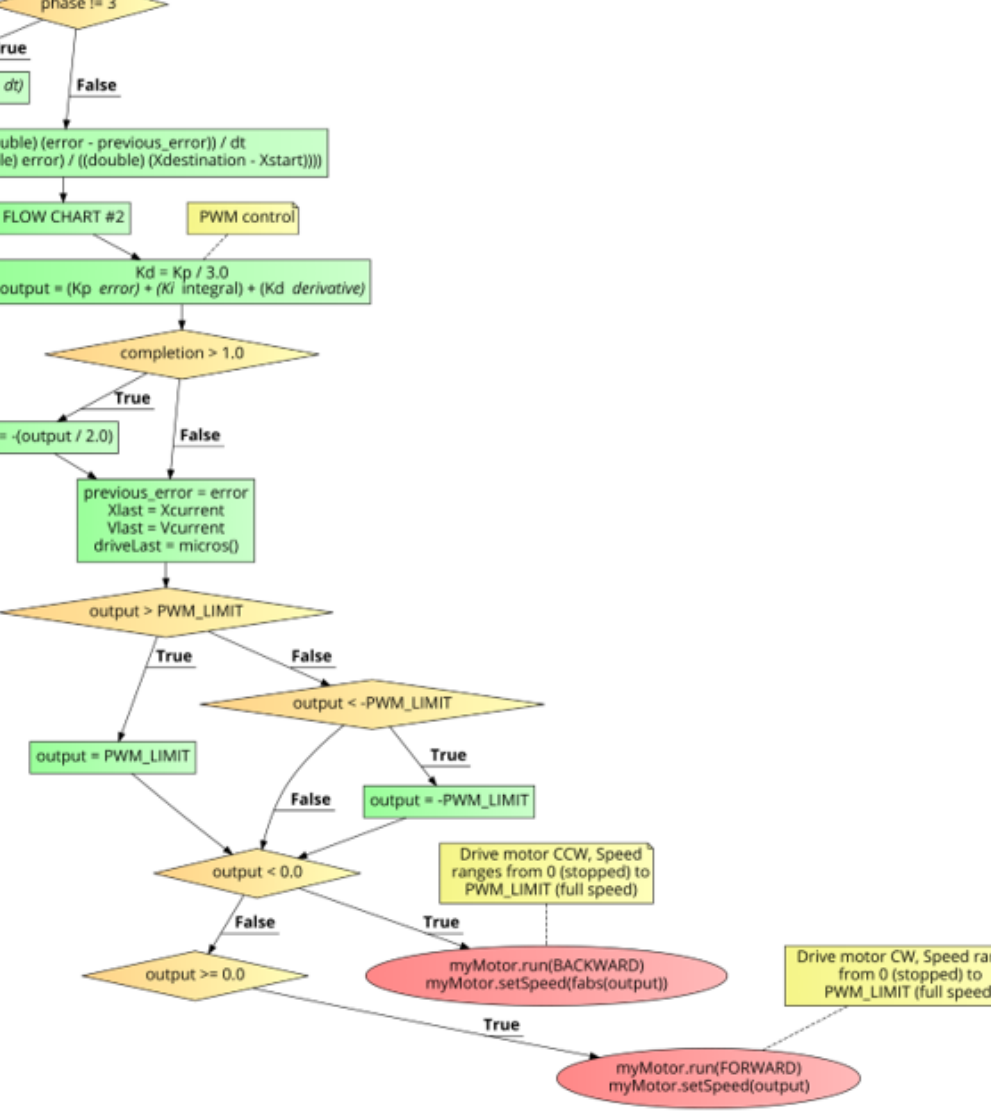
Figure 8. PID++ Flow Chart #1—output control